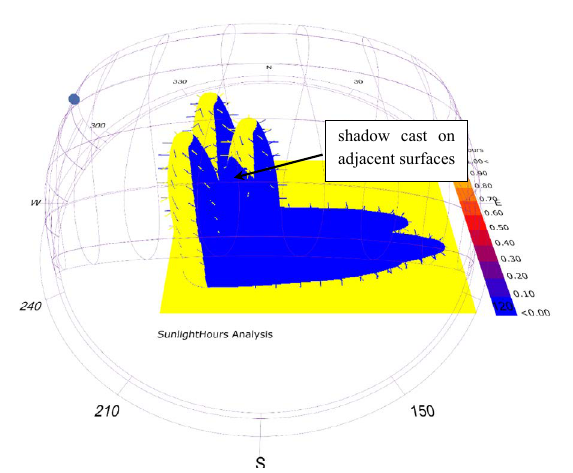
Figure 5. An Ecotect analysis of the shadow cast on the surfaces of the pigeon towers at 16